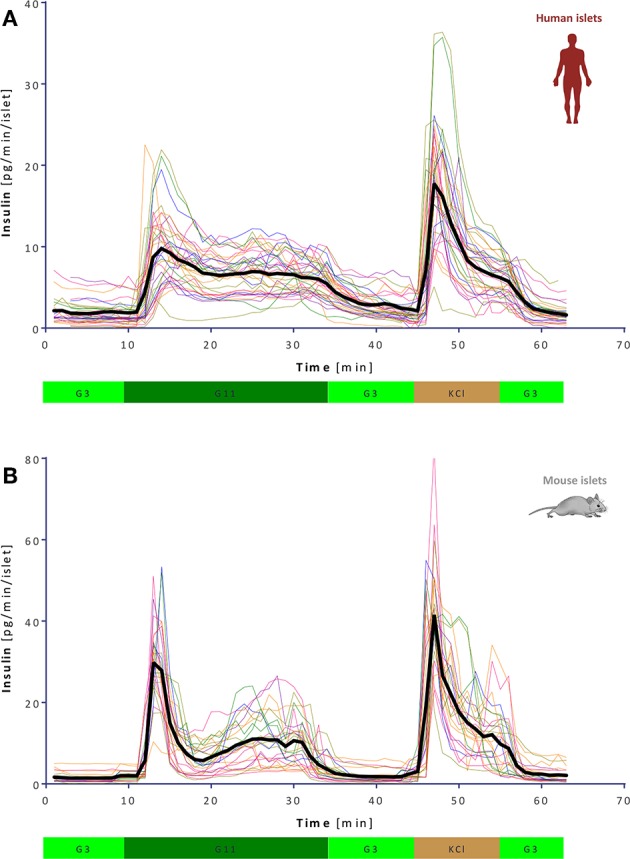
Variability of dynamic GSIS in isolated human and mouse islets. All experimental data for human (A) and mouse (B) islets perifused as before (G3 → G11 → G3 → KCl, see Figure 1) shown together with their overall average (thick black line; n = 34 and 25, respectively).